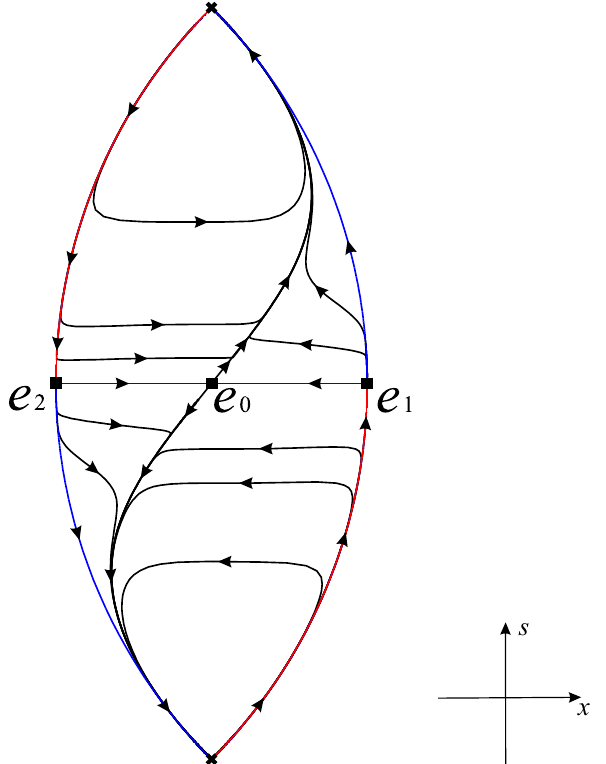
Fig. 1 The phase portraits of the invariant plane z = 0 in the region − 1 ≤ x ≤ 1 Table 1 Equilibrium points and their characteristics on the invariant plane z = 0 for all s ∈ R x s Stability ω M (cid:9) DE ω DE Equilibrium points